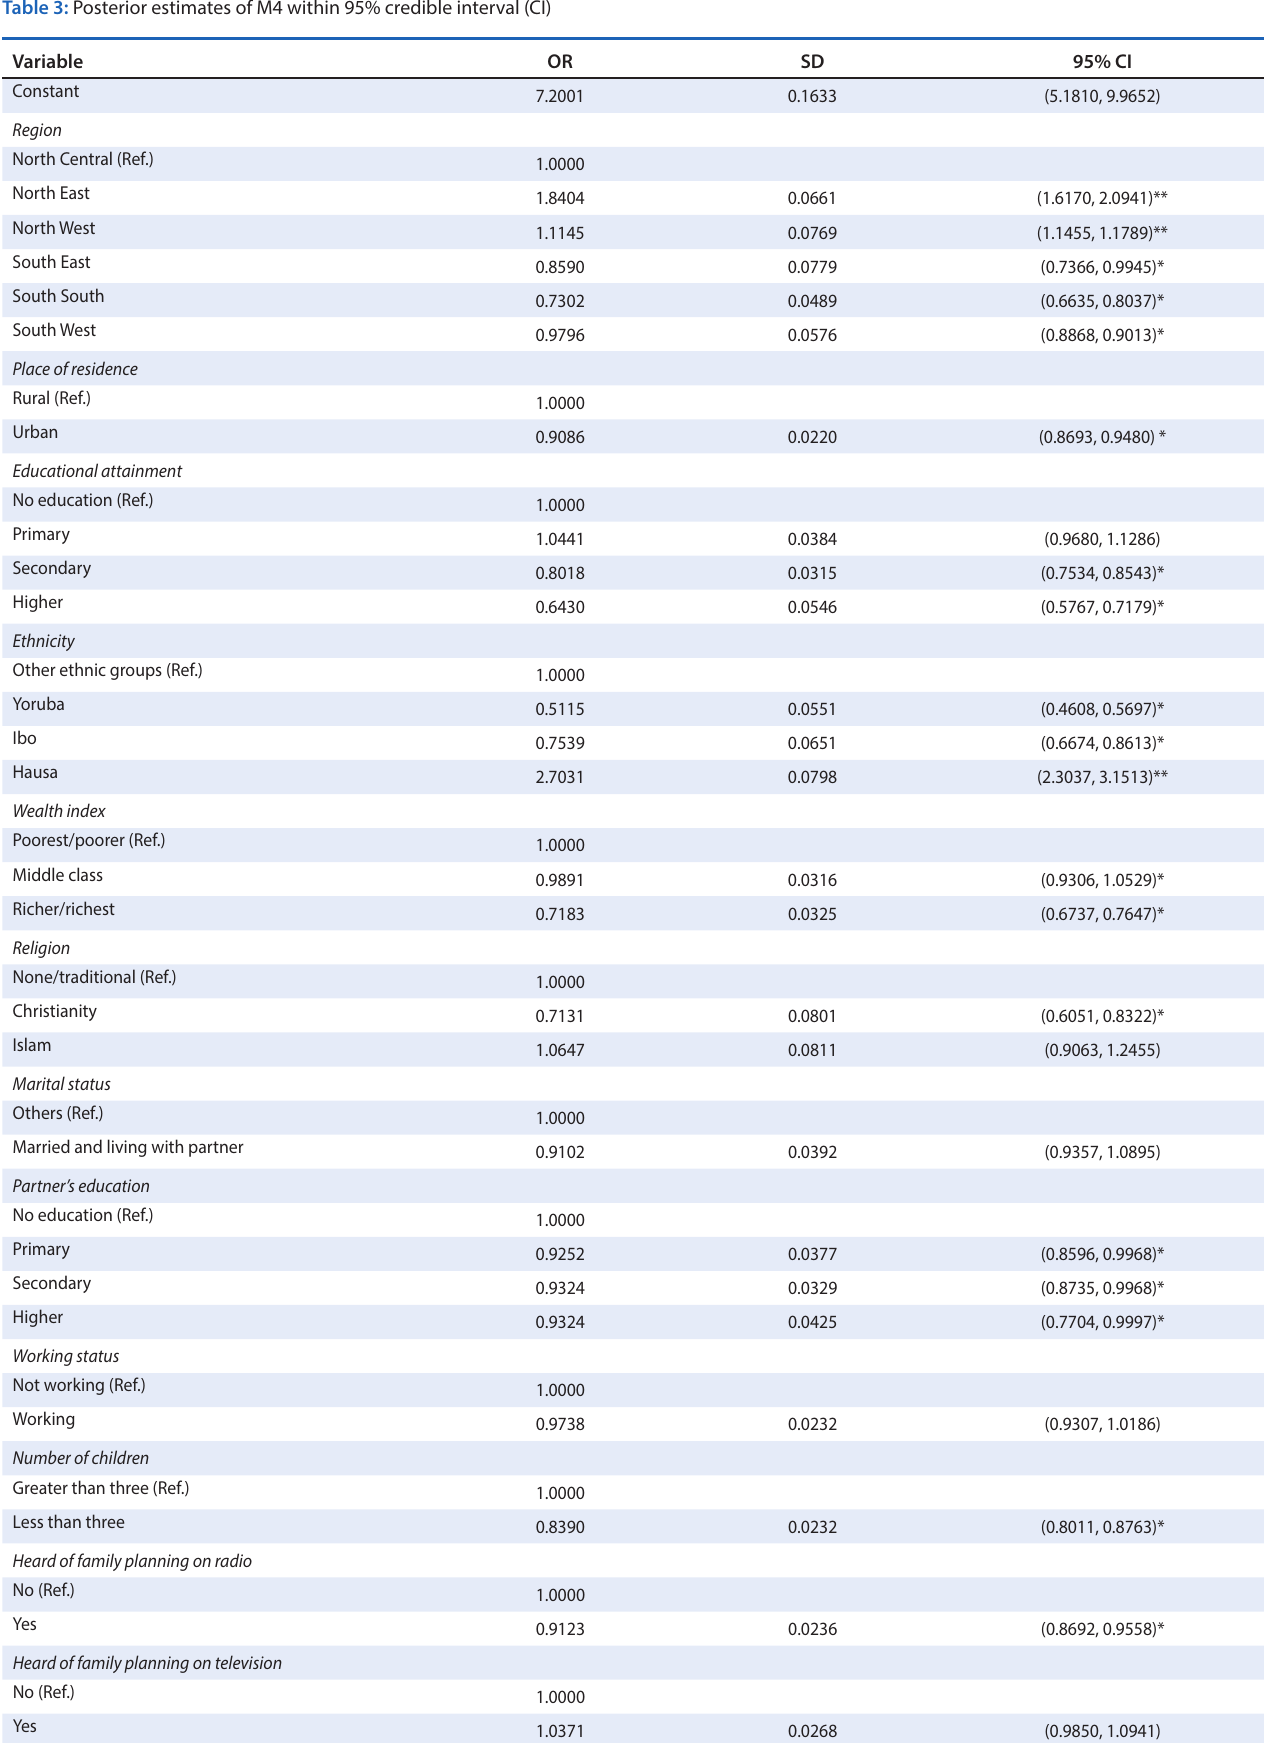
Table 3: Posterior estimates of M4 within 95% credible interval (CI)